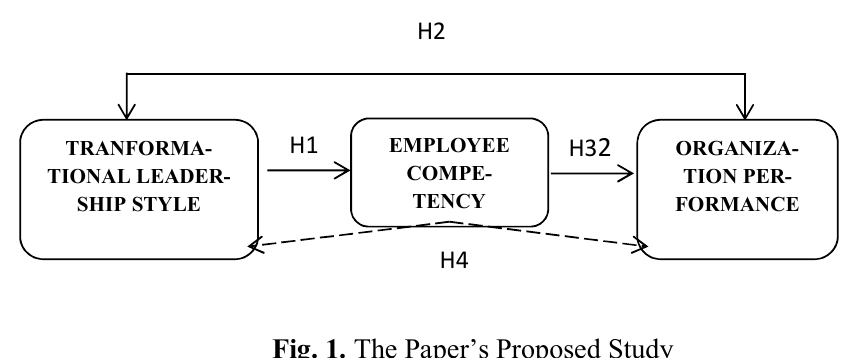
Fig. 1. The Paper’s Proposed